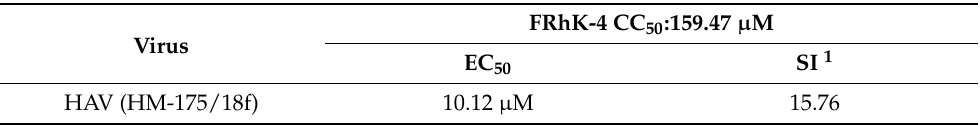
Figure 1. Changes in the amount of HAV RNA and HO-1 induction in FRhK-4 cells according to the concentrations of hemin. ( A ) FRhK-4 cells infected with HAV strain HM-175/18f, clone B (10 GE/cell) were treated for 72 h without or with various concentrations of hemin. As the concentration of hemin increased, the amount of HO-1 mRNA increased as expected, and HAV RNA decreased accordingly. ( B ) Cell viability percentages (compared to hemin-untreated cells) of FRhK-4 cells at 72 h post-treatment with the indicated concentrations of hemin. ( C ) Changes in HO-1 and HAV proteins according to hemin concentration. As the concentration of hemin increased, the HO-1 protein band became thicker and the amount of viral proteins decreased. GAPDH, a housekeeping protein, showed that the same number of cells was used in this experiment. Data are presented as the mean ± standard deviations (SD) of at least 3 independent experiments. Table 1. Cytotoxic concentration (CC 50 ) and effective concentration (EC 50 ) of hemin in FRhK-4 cell line and hepatitis A virus.